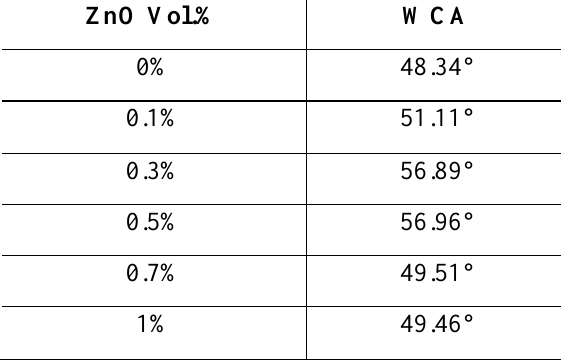
Table 2: WCA of ZnONPs/Epoxy